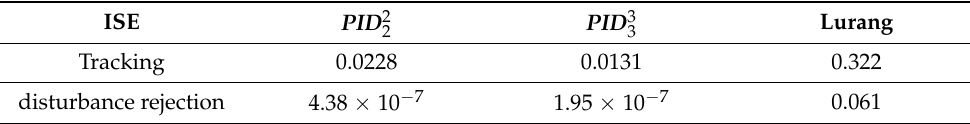
Table 7. The ISE values for all three controllers in tracking and disturbance rejection.